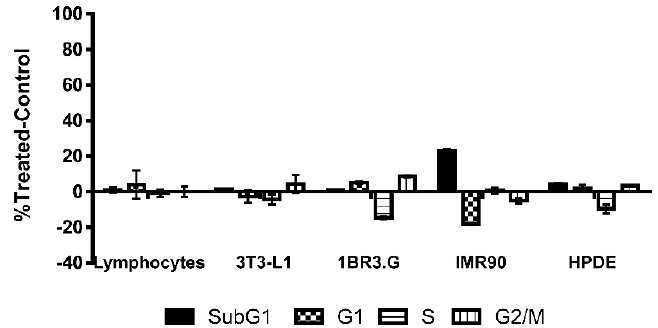
Figure 3. CLytA-DAAO effects on cell cycle distribution in non-tumor cell lines. Primary culture of lymphocytes, 3T3-L1 adipocytes, 1BR3.G, and IMR90 fibroblasts cell lines and HPDE human pancreatic cells were treated with 2 U mL − 1 CLytA-DAAO and 1 mM D-Ala for 24 h and cell cycle distribution was determined by flow cytometry. Data represent the mean ± SEM of the percentages of treated cells minus those of the control untreated cells with n ≥ 3.